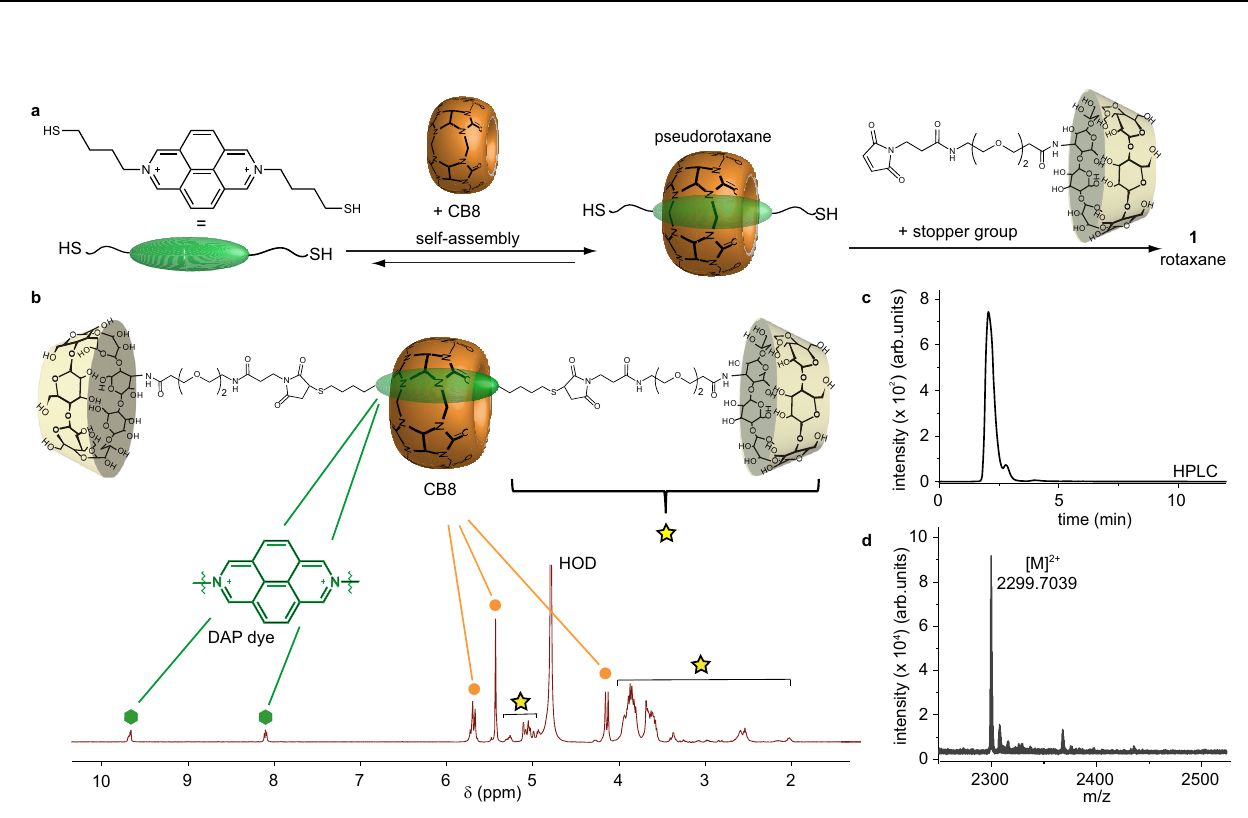
serum and urine.The hydrophilicand bulky β -cyclodextrinmoieties act asstopper groups that prevent CB8 • dye disintegration in bio fl uids, protect rotaxane 1 from adverse interactions with serum proteins, and enable its covalent anchoring to a surface for sensor chip preparation.